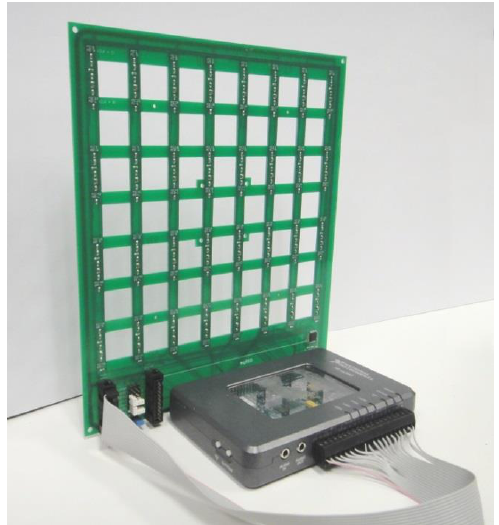
Figure 1. Array module with myRIO and MEMS array board.